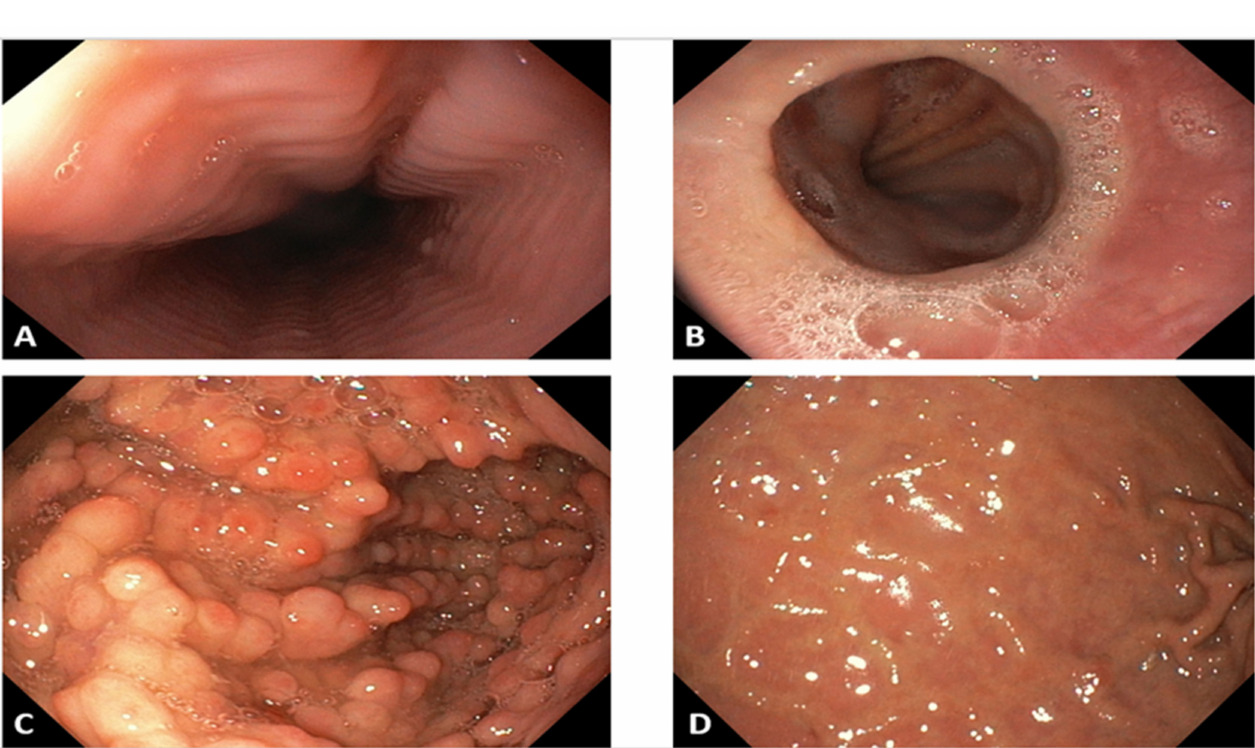
Figure 1. Endoscopic findings of the oesophagus and stomach at EGE diagnosis 2017 (performed